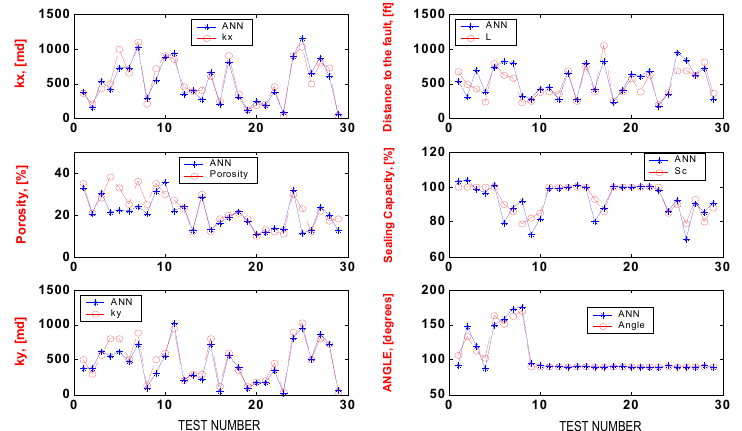
Figure 10. Comparison of the predicted and actual characteristics of a faulted reservoir.